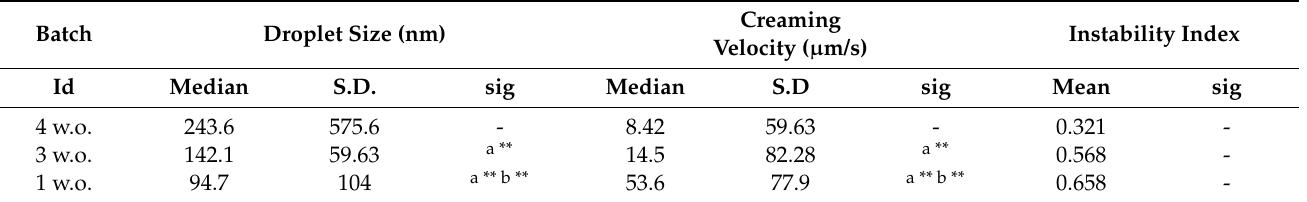
Table 1. Accelerated stability characterization parameters of the developed NCTD nanoemulsion, for different